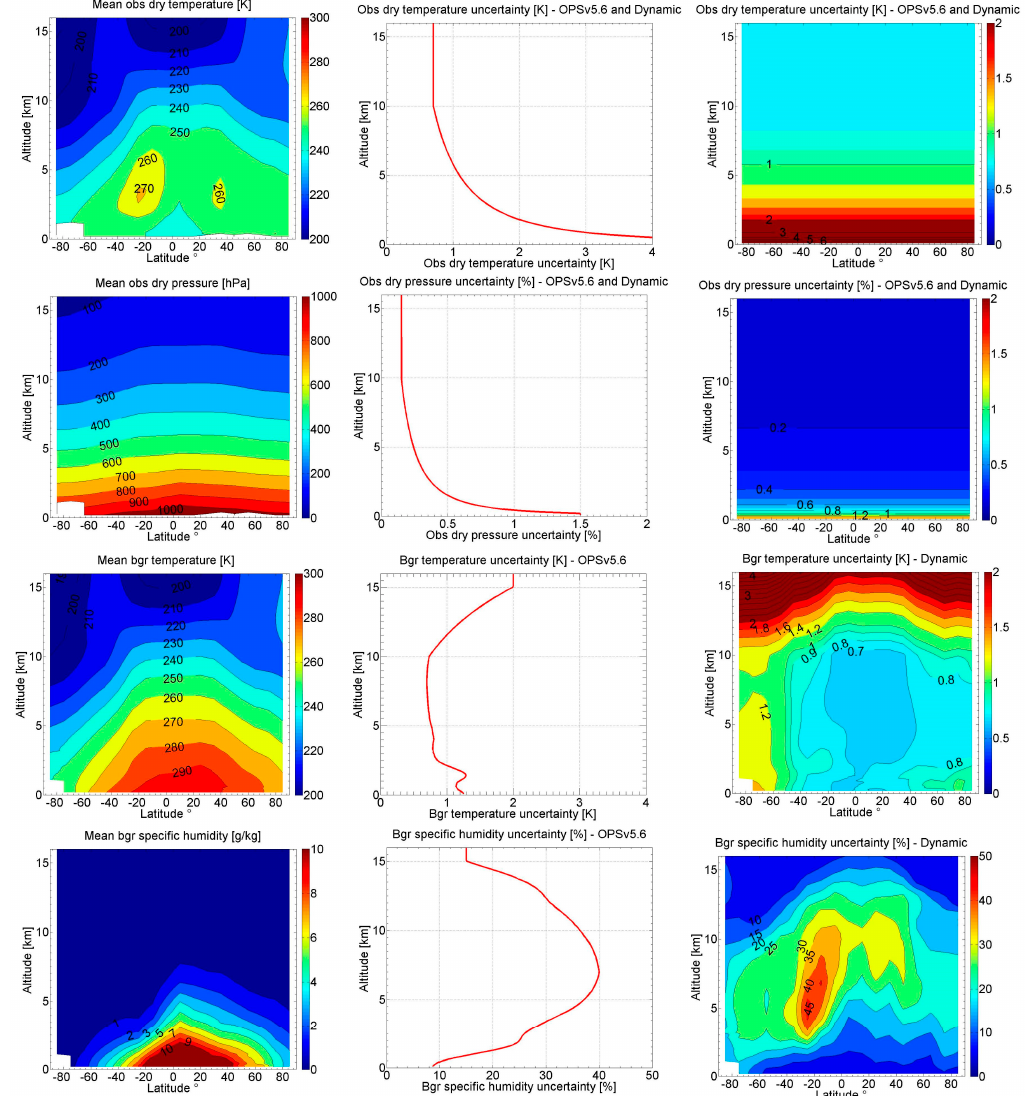
Figure 2. Mean profiles and uncertainties of the four input variables, i.e., observed dry temperature (first row), observed dry pressure (second row), background temperature (third row), and background specific humidity (fourth row) on 15 July 2008. For the input observed profiles (first row and second row), which the OPSv5.6 and the dynamic approach share the same uncertainties, the left, middle, and right panels show for the observed mean profile, uncertainty profile as a function of altitude, and the uncertainty profile as a function of altitude and latitude, respectively. For the background profiles (third and fourth row), the left, middle, and right panels show for the background mean profile as a function of altitude, global mean static uncertainty profile of OPSv5.6 approach as a function of altitude, and dynamic background uncertainty as a function of altitude and latitude, respectively.